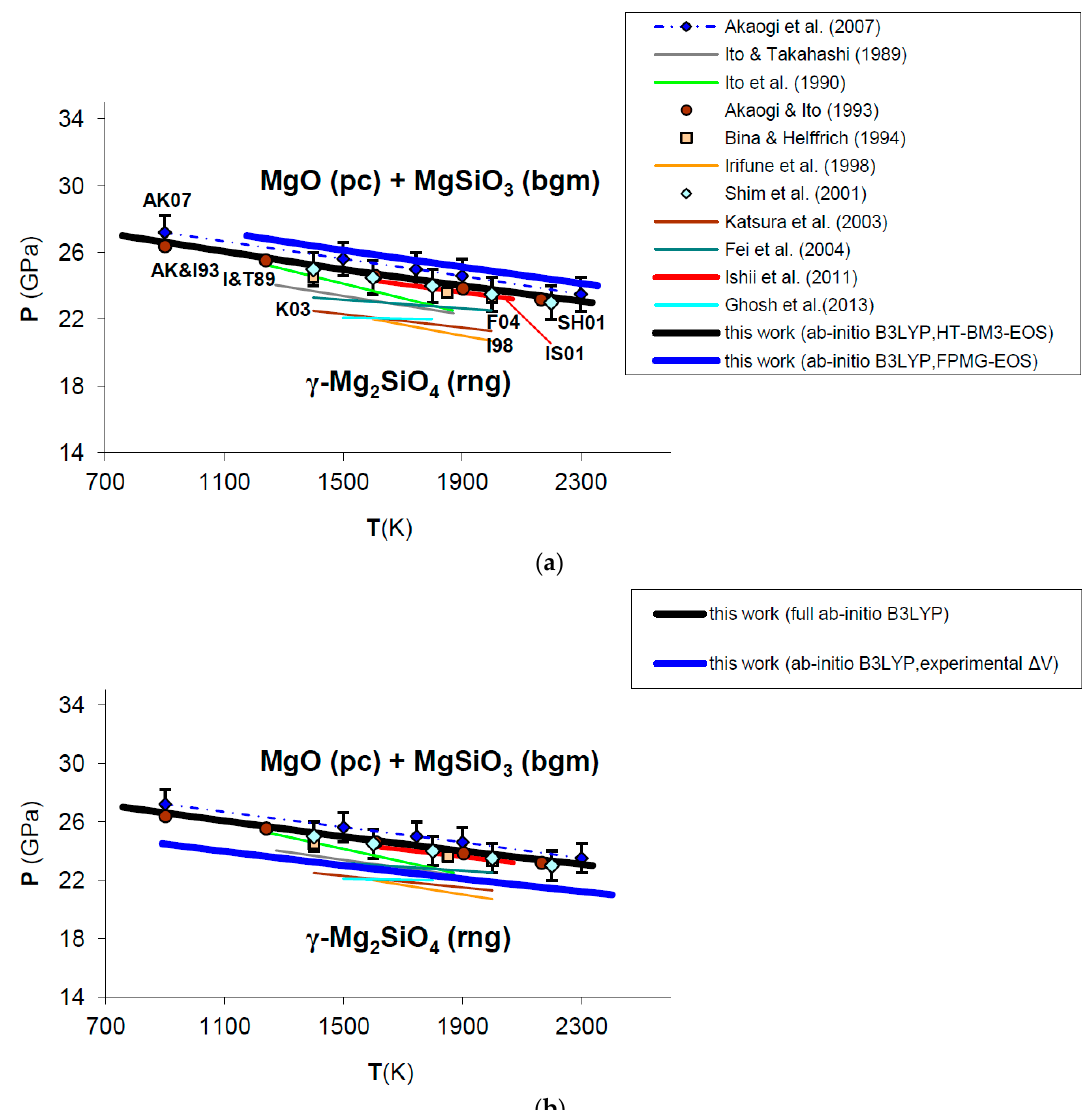
Figure A1. Effects of EOS and thermodynamic parameters on the post-spinel phase equilibrium: ( a ) ab initio B3LYP phase boundary calculated by adopting either a FPMG-EOS (blue line, in bold) or a HT-BM3-EOS (black line, in bold) for MgO; ( b ) ab initio B3LYP phase boundary calculated by adopting either ab initio volumes (black line, in bold) or experimental volumes (blue line, in bold) for all phases in the reaction. Experimental results are shown for comparison (cf. Figure 11). Abbreviations for minerals and labels as in Figure 11.